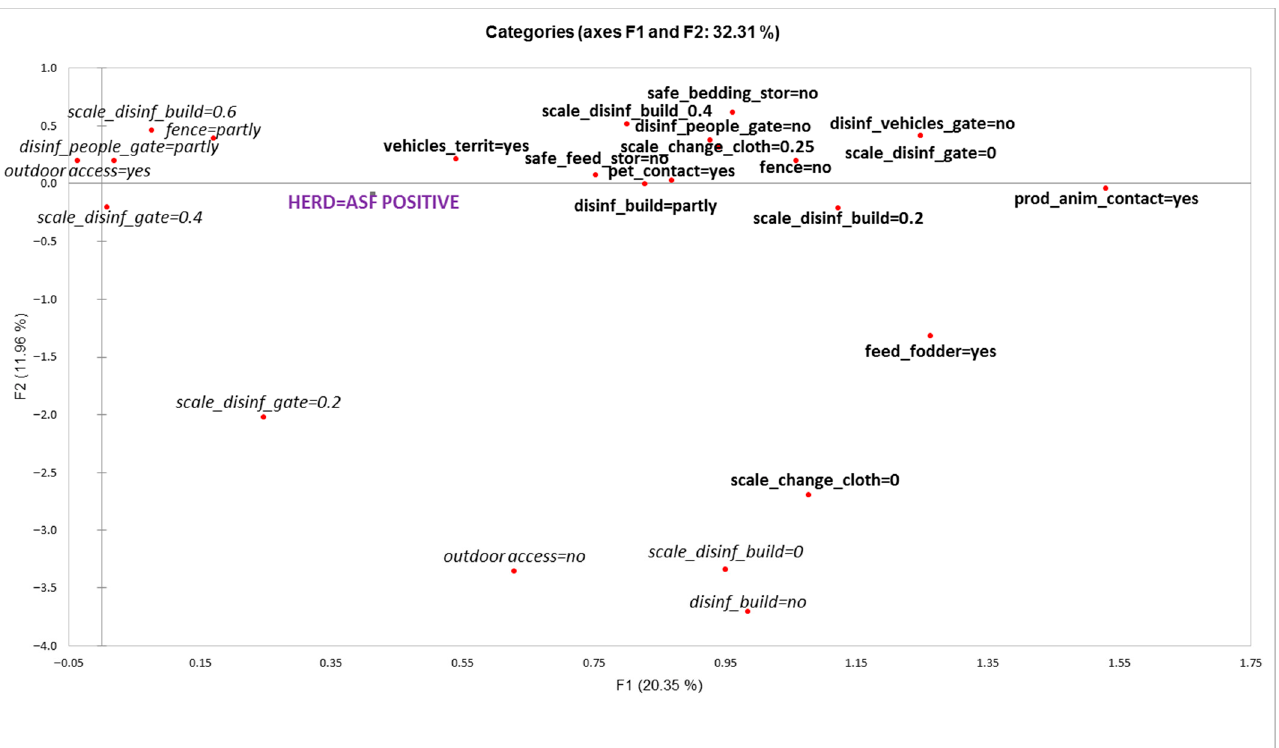
Figure 3. Graphical display of multiple correspondence analysis for variables of biosecurity compo- nents associated with herd “outbreak” status (variable categories presented in bold are significantly associated with farm “outbreak” status).